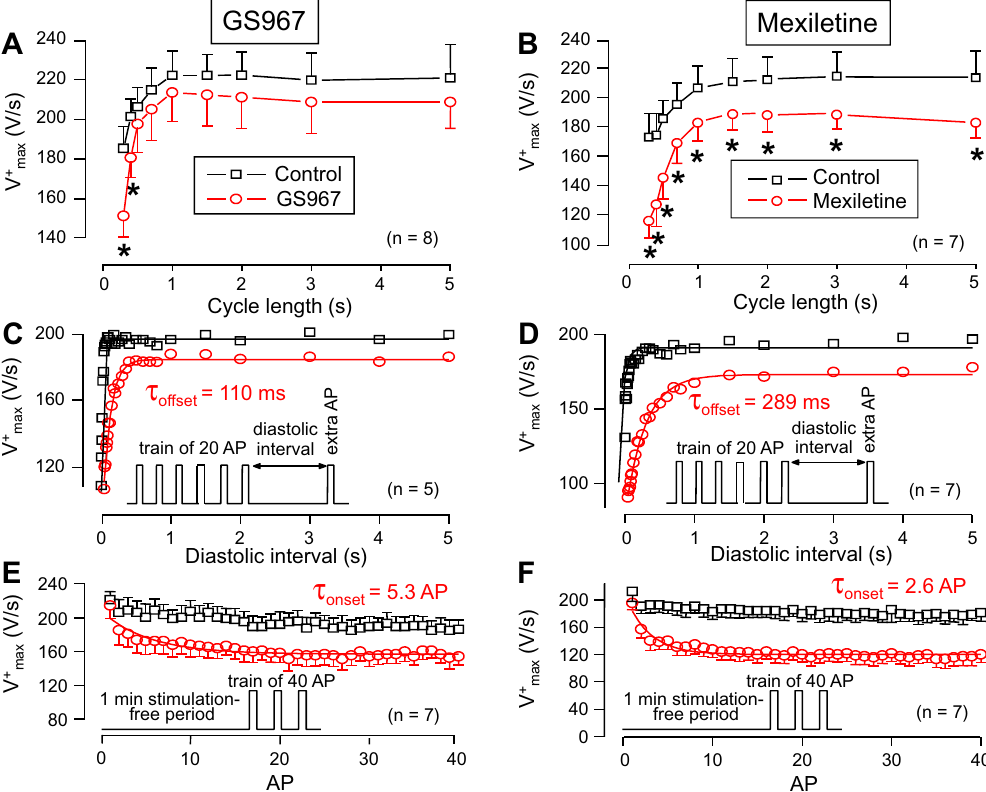
Figure 4. Effects of 1 µM GS967 ( A , C , E ) and 40 µM mexiletine ( B , D , F ) on the maximal rate of depolarization (V + max ) measured in canine right ventricular trabeculae. ( A , B ) Cycle length-dependent effects on V + max under steady-state conditions. ( C , D ) Determination of offset kinetics of GS967 and mexiletine as indicated by the time-dependent restitution of V + max . ( E , F ) Determination of the onset kinetics of the V + max -block at 2.5 Hz. The respective protocols are shown in the insets — for further details see Methods section. Solid lines were obtained by monoexponential fitting. Symbols and bars are mean ± SEM, numbers in parentheses indicate the number of preparations studied, asterisks denote significant differences between data of the pre-drug control and the GS967- or mexiletine-treated